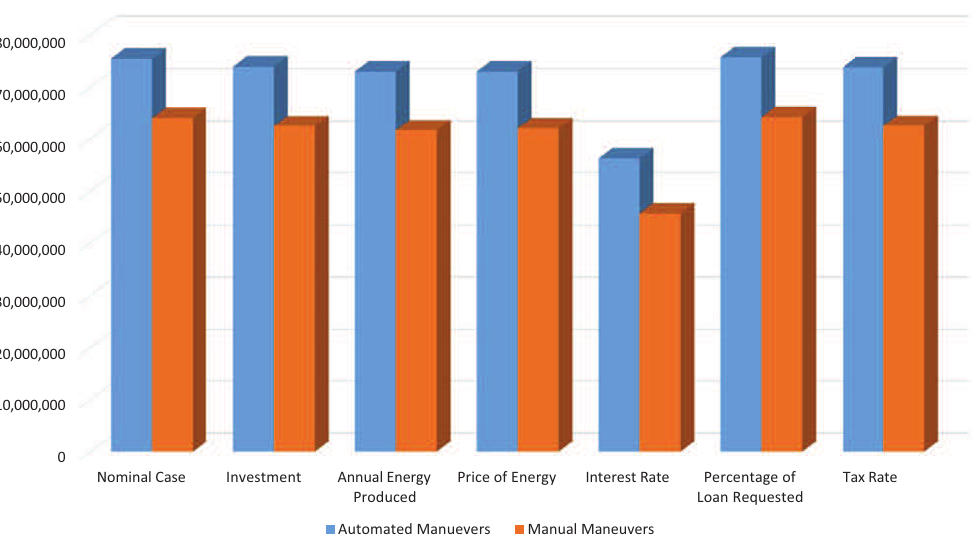
Figure 18. NPV (Net Present Value) results of the project when manual and automated maneuvers are carried